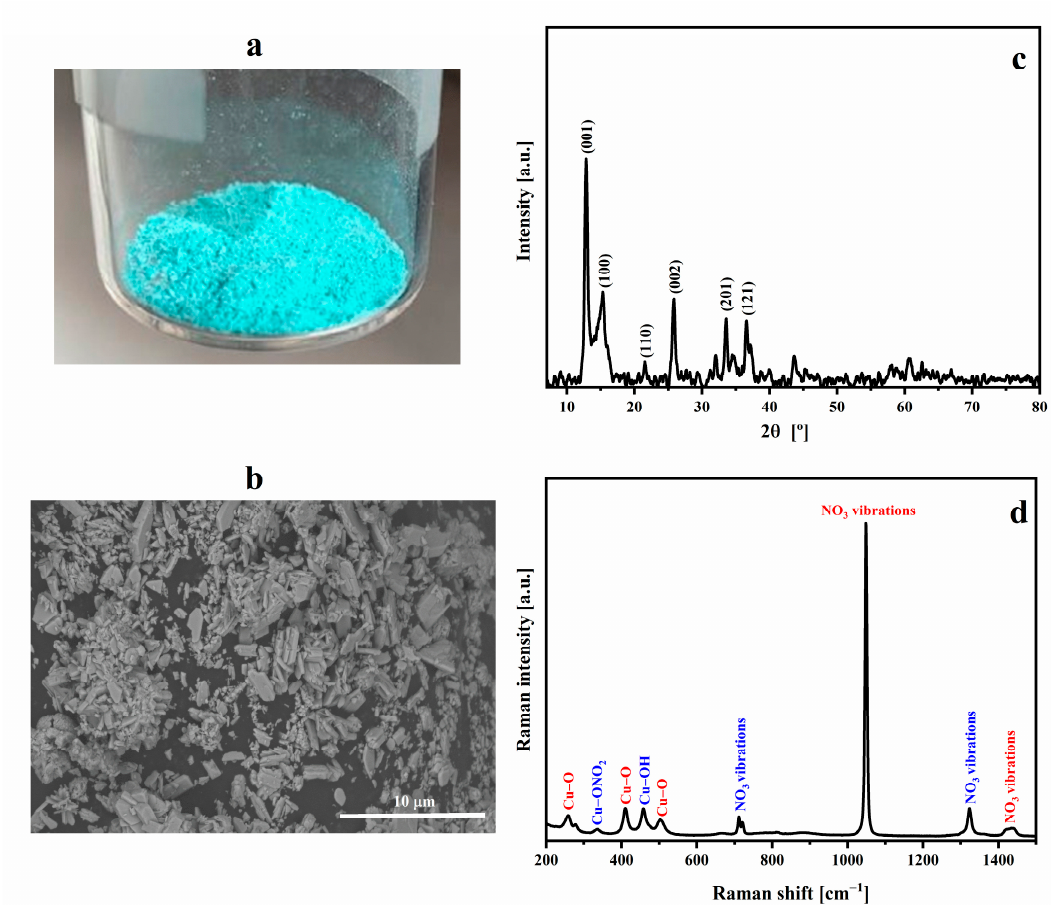
Figure 1. ( a ) Macroscopic aspect; ( b ) FESEM (scale 10 µm); ( c ) XRD with the assignment of the observed planes; and ( d ) Raman spectroscopy of the synthesized CuHS.